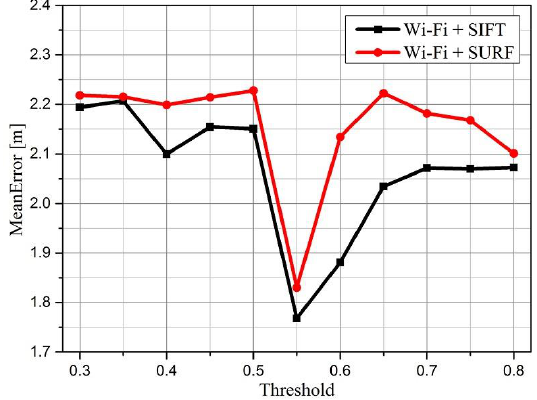
Figure 10. Different thresholds’ impact on positioning accuracy.